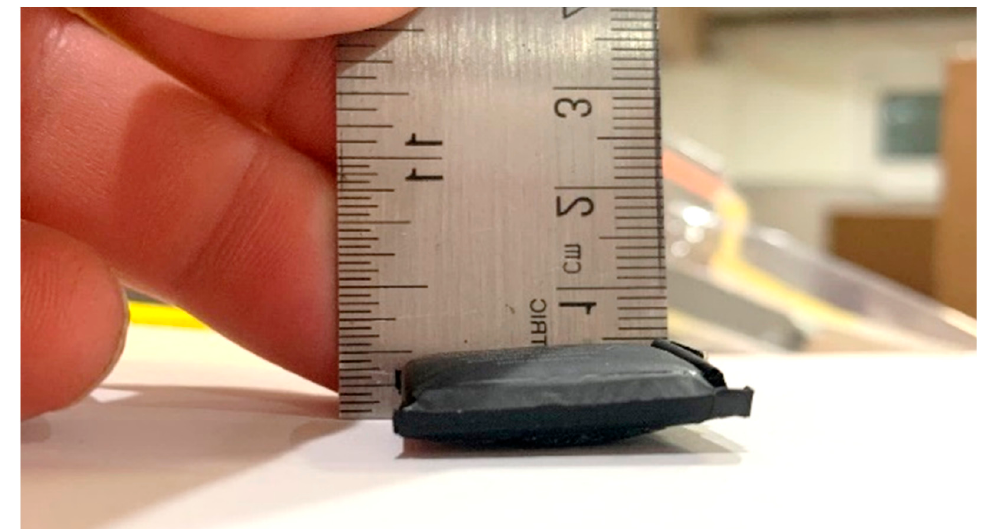
Figure 1. A swollen pouch